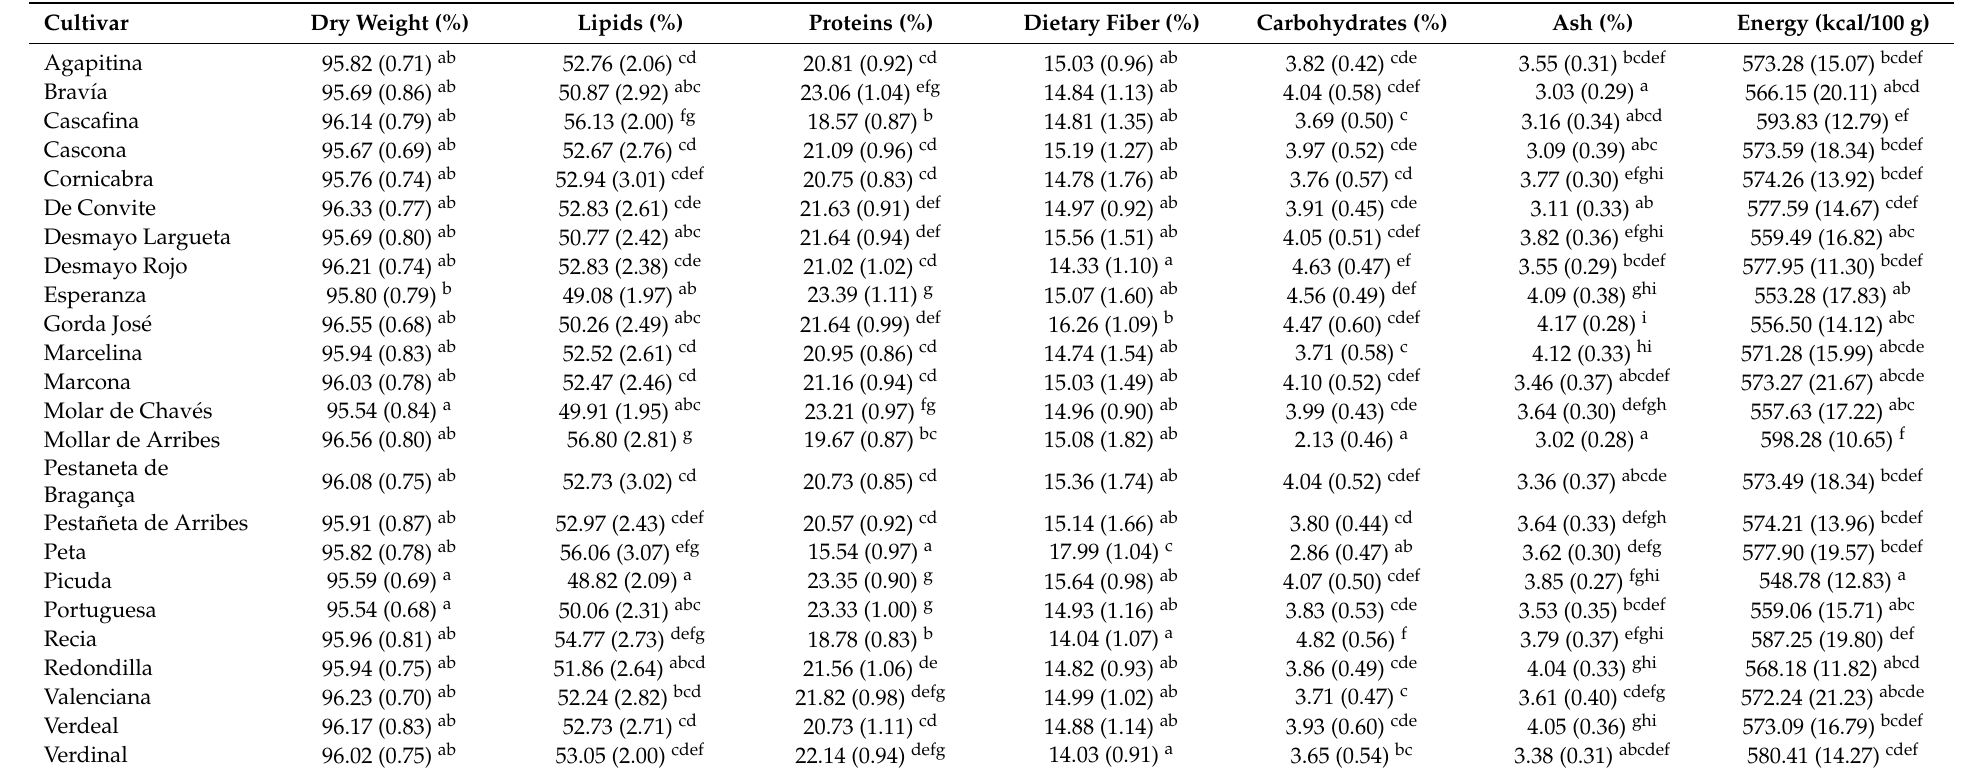
Table 4. Means, standard deviations and ANOVA analyses for some parameters of nutritive composition in almond